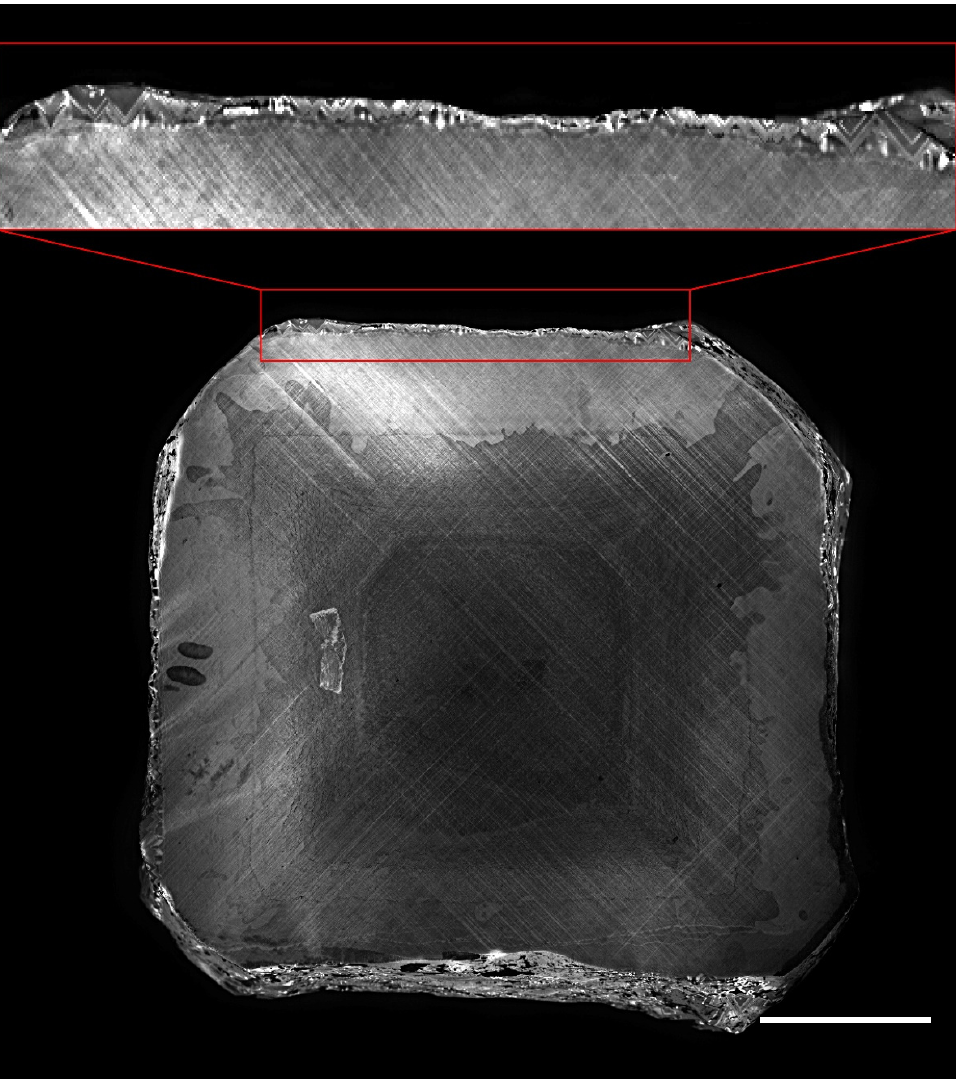
Figure 5. CL image of a plate, cut from the center of cuboid diamond in <100> direction, with internal structure of normal growth. The enlarged part (boxed in red) demonstrates the regeneration zoning in the peripheral zone of the crystal. Thin diagonal lines are {111} layers of plastic deformation, crossing the entire crystal. The scale bar is 1 mm.